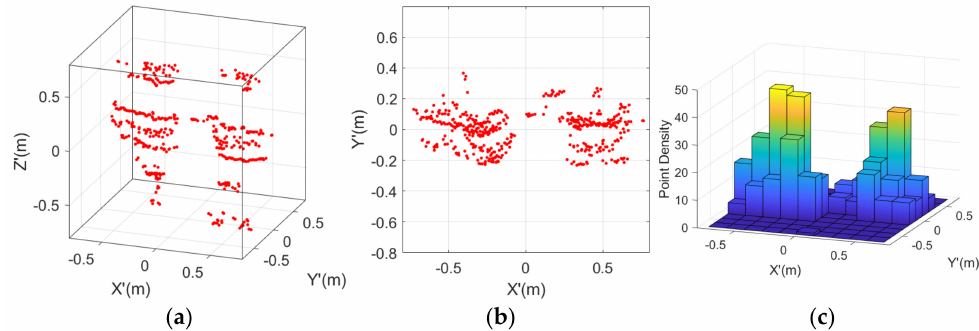
Figure 4. Two pedestrians walking close by: ( a ) point cloud; ( b ) the projected image in the tertiary plane; ( c ) point density